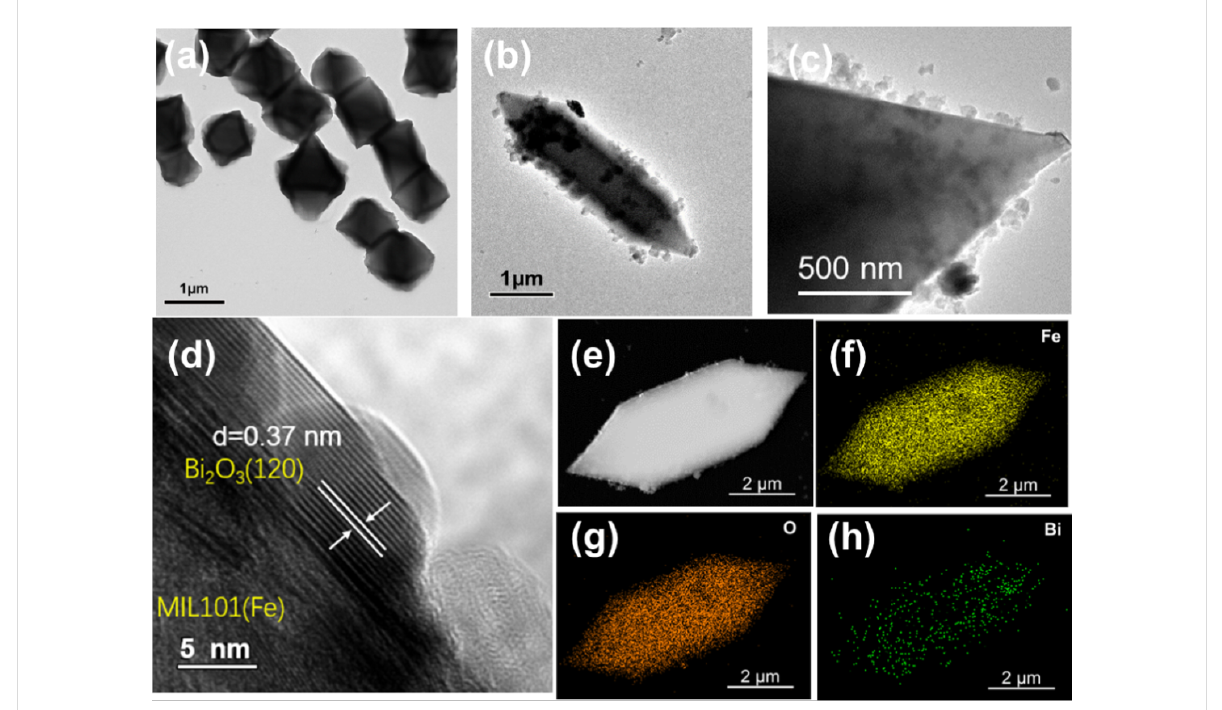
Figure 3: TEM image of (a) MIL101(Fe) and (b, c) BOM-20. (d) HRTEM image of BOM-20. (e) HAADF-STEM image of BOM-20 and the correspond- ing elemental maps of (f) Fe, (g) O, and (h) Bi.